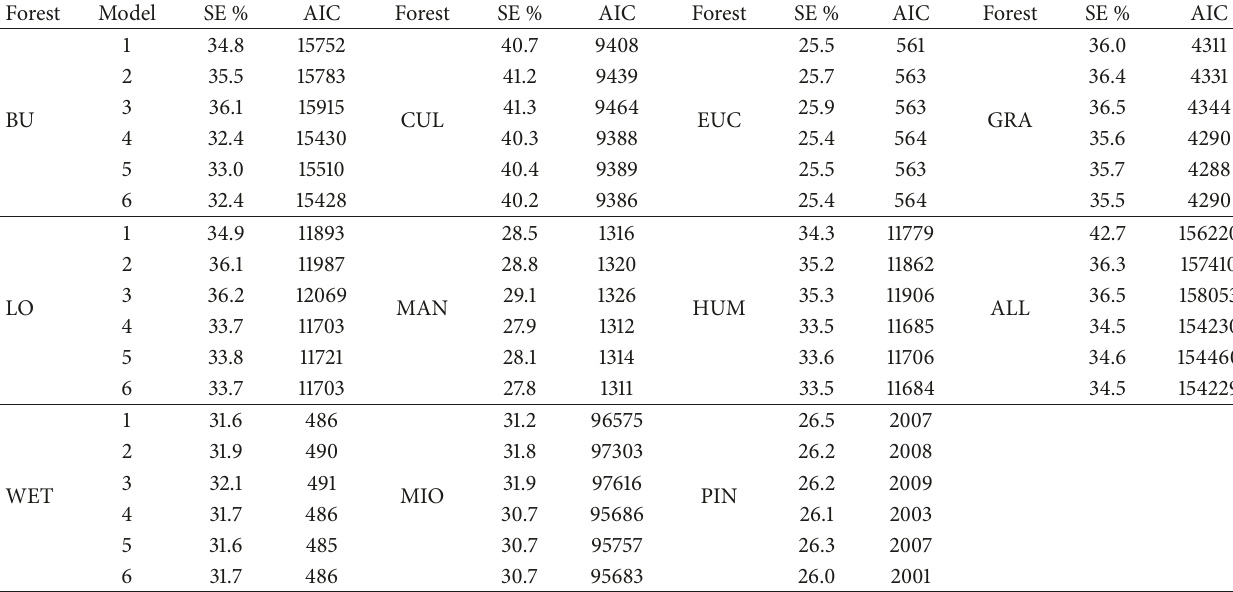
Table 3: Parameters estimates and performance of height base